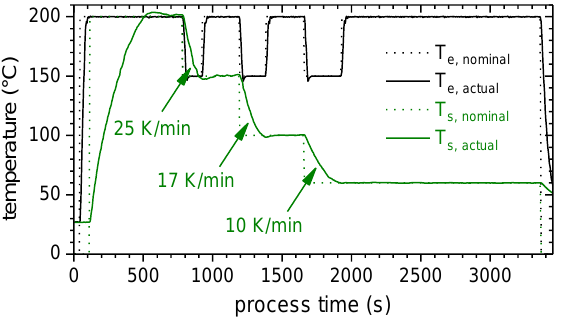
Figure 1. Temperature time profile of the nominal and actual temperature of the extruder and the substrate during production of a single lap joint (SLJ) specimen. The substrate temperature, T s , was gradually decreased after each layer. Cooling rates represent averaged values.